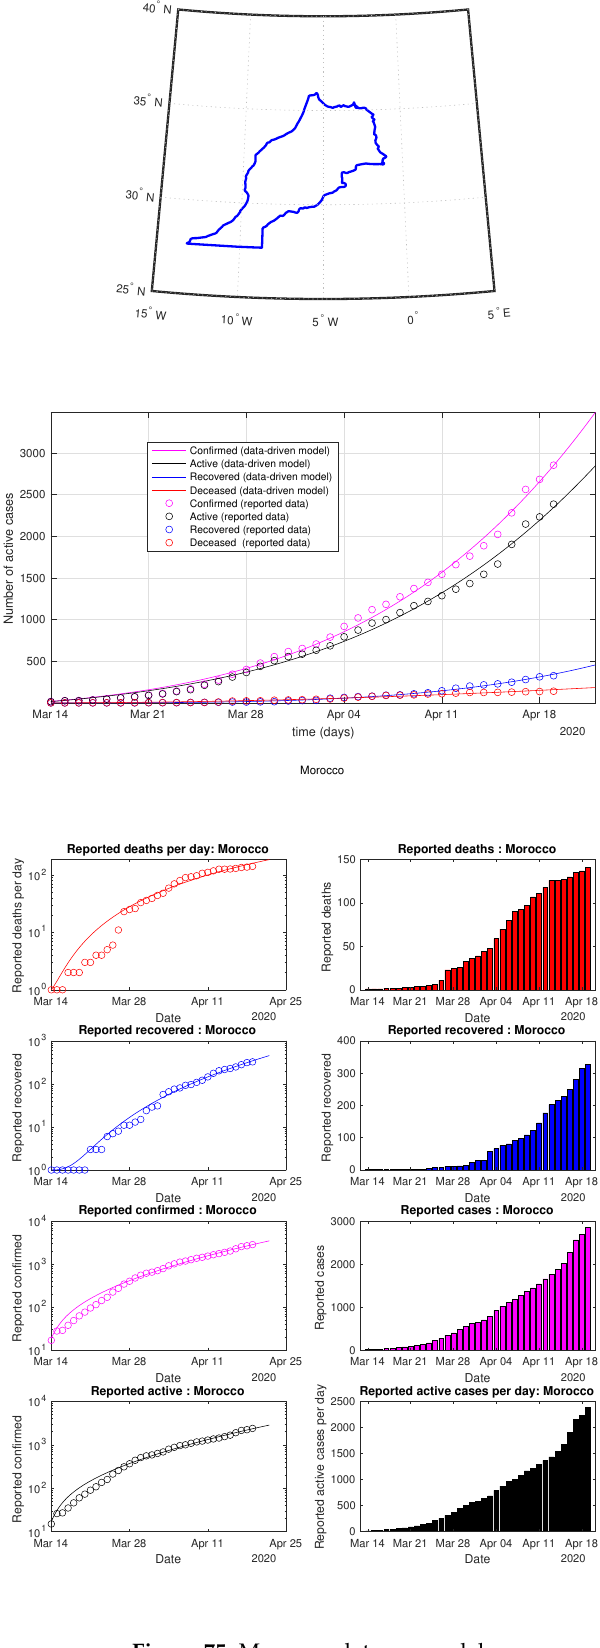
Figure 75. Morocco: data vs.